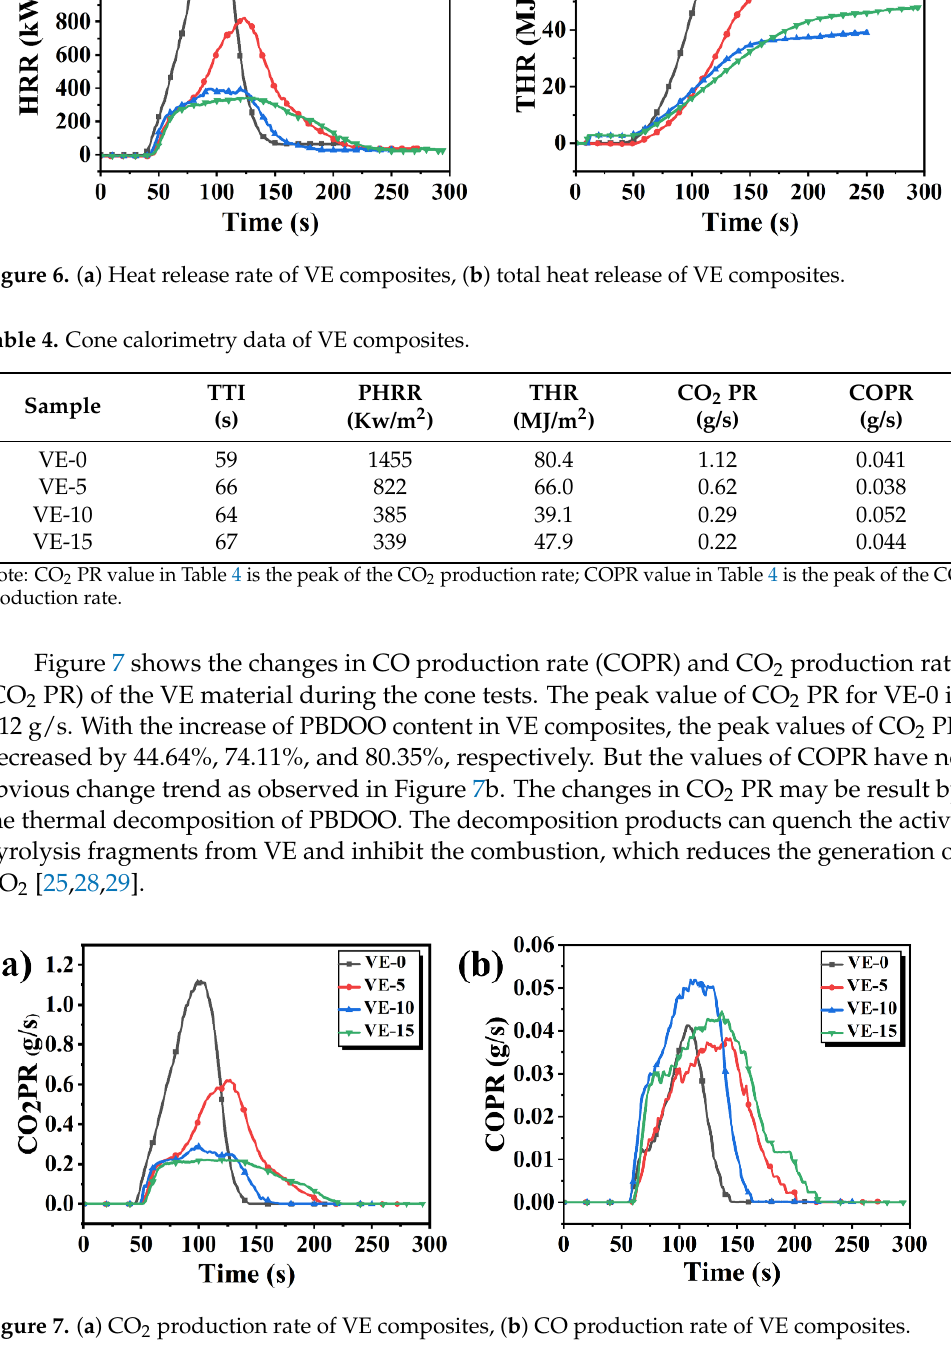
Figure 7. ( a ) CO 2 production rate of VE composites, ( b ) CO production rate of VE